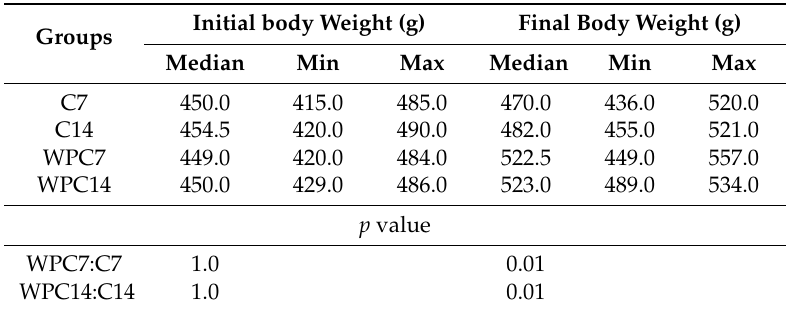
Table 1. Body weight of rats from control and experimental groups. Abbreviations: C7, C14, control groups; whey protein concentrate (WPC)7, WPC14, experimental groups treated WPC-80. Data are presented as median, minimum and maximum. Because the results were not normally distributed, the Mann–Whitney test was used to compare differences between the studied groups.